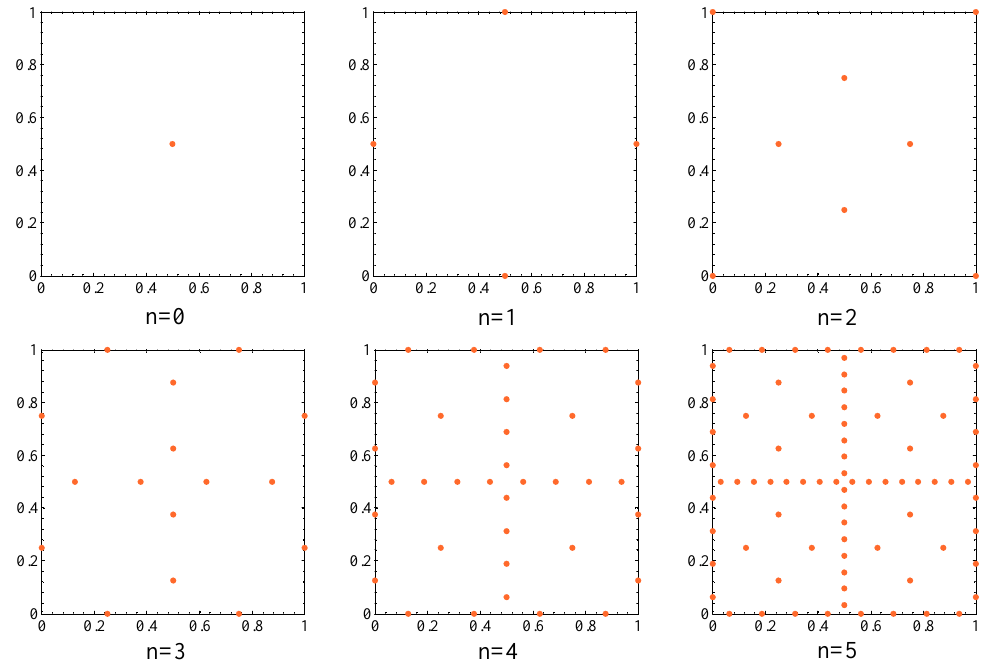
Figure 3. Illustration of the Clenshaw–Curtis sparse grid sampling point locations for an exemplary two-dimensional problem, at varying degree d of the interpolation. Table 2. Clenshaw–Curtis sparse grid sampling: dependence on the interpolation degree d of